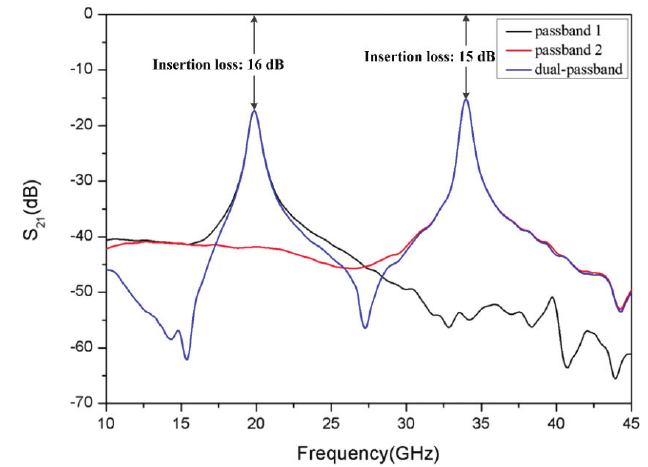
Figure 6. Results of the improved out-of-band suppression ratio by adjusting the power and phase of two links.